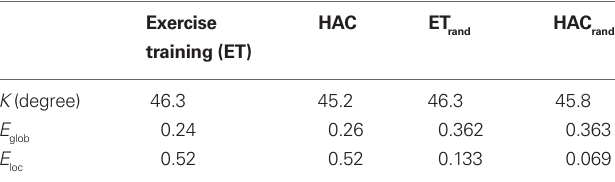
and E , respectively). ET and HAC glob loc rand rand